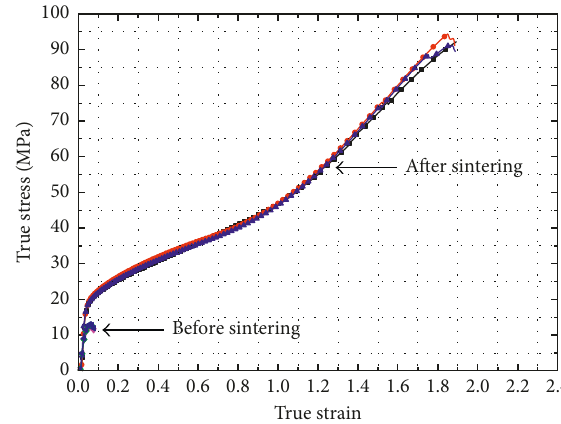
Figure 1: The temperature history of the sintering